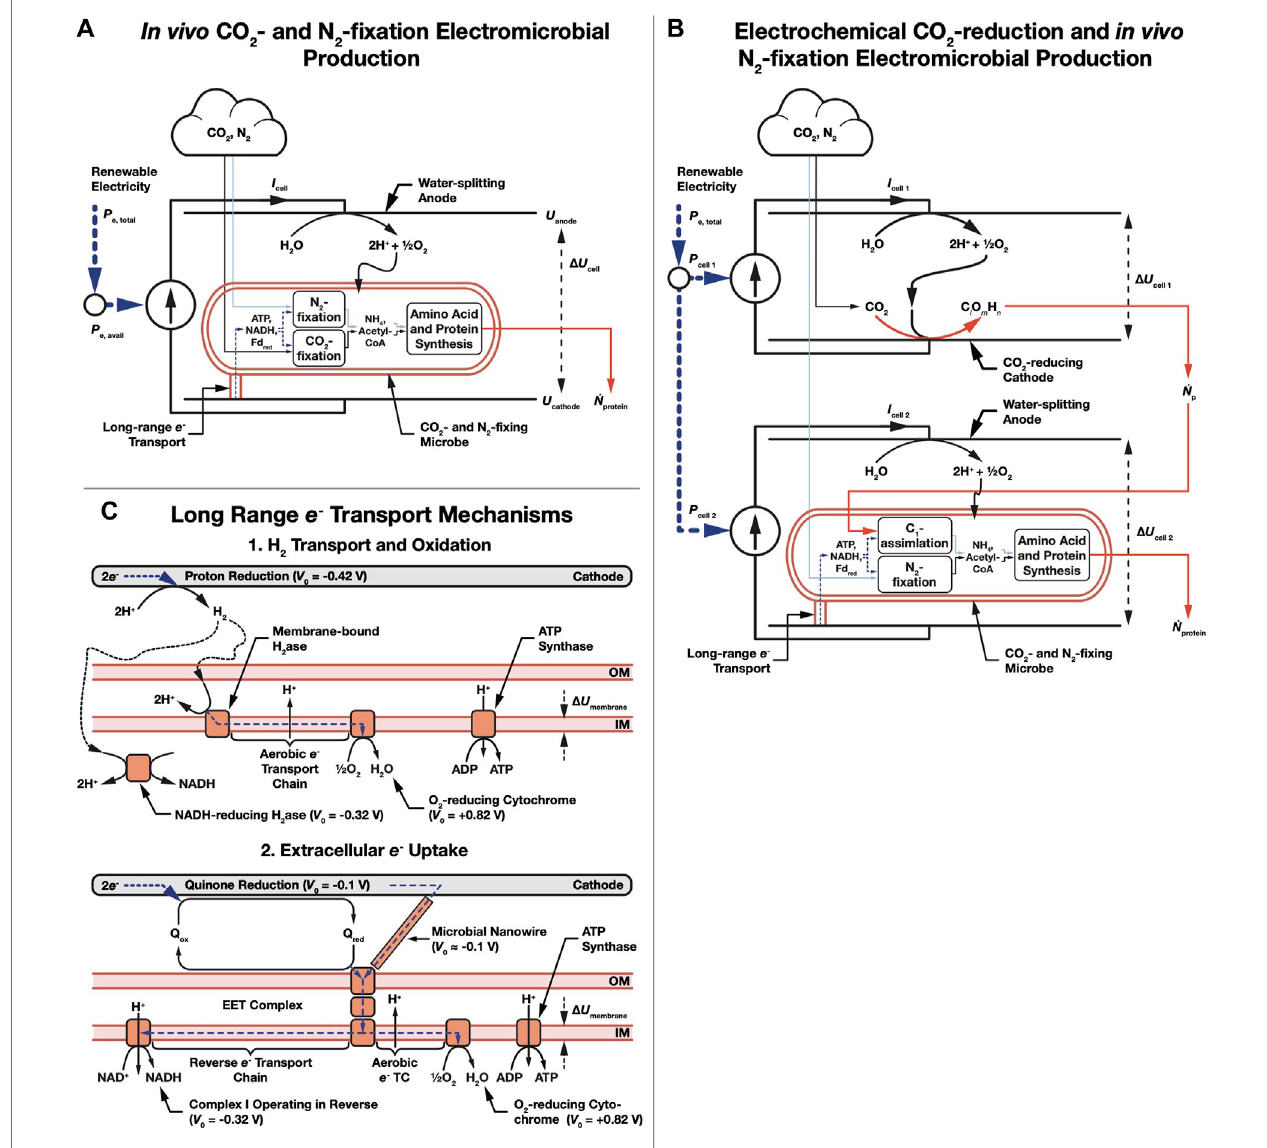
FIGURE1| Schematicofaminoacidelectromicrobialproductionsystems. (A) Singlebio-electrochemicalcellsystemwhereelectricityisusedtopower invivo CO 2 - andN 2 - fi xation. (B) DualelectrochemicalcellsystemwhereCO 2 isreducedinthe fi rstcell,andthenassimilatedinthesecondcell,andcombinedwithenzymatically fi xed N 2 . (C) Long range e- transfer mechanisms considered in this article. In the fi rst, H 2 iselectrochemically reduced on acathode, transferred to the microbe by diffusion or stirring, and is enzymatically oxidized. In the second mechanism, extracellular electron uptake (EEU), e- are transferred along a microbial nanowire (part of